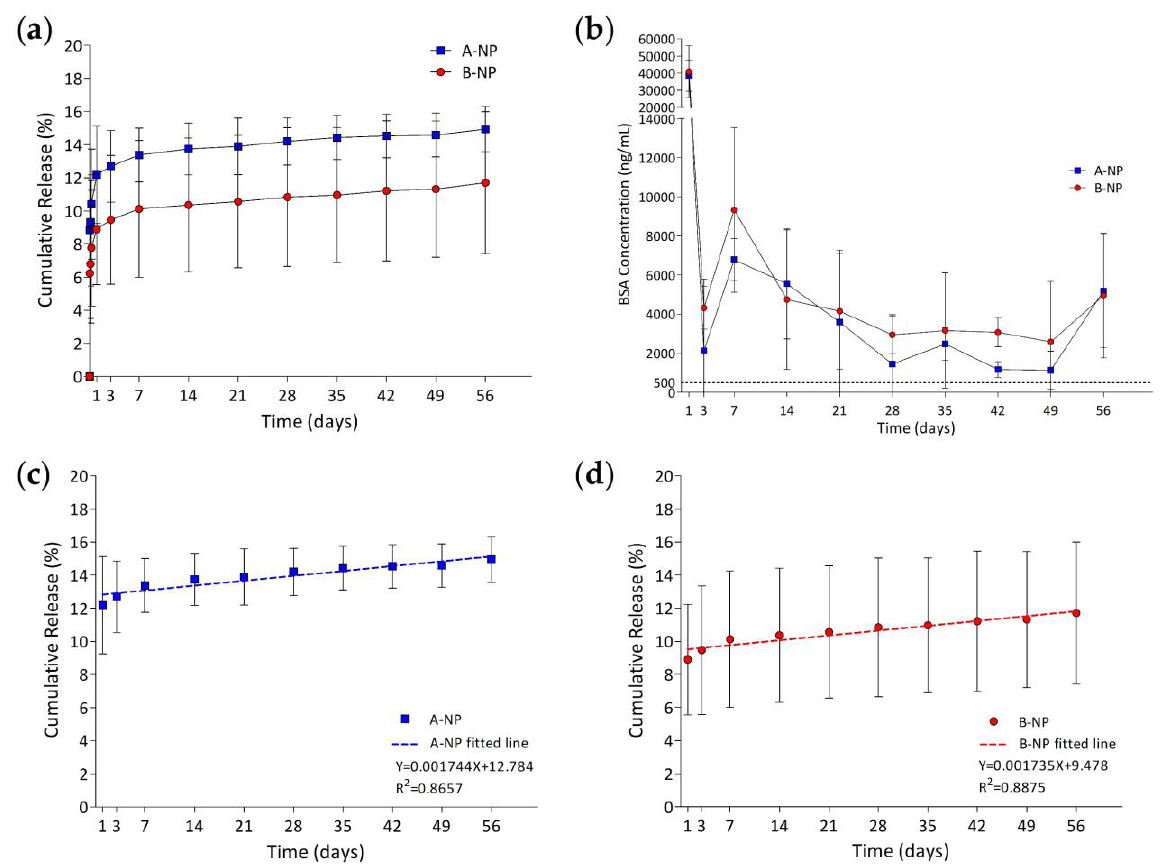
Figure 6. ( a ) Cumulative release percentage and ( b ) BSA release concentration of group A-NP and group B-NP. The dashed line indicates the minimum anti-VEGF drugs needed to block VEGF effectively, which was 500 ng/mL. Linearly fitted lines of group ANP and group BNP releasing BSA are shown in (c) and ( d ), respectively.